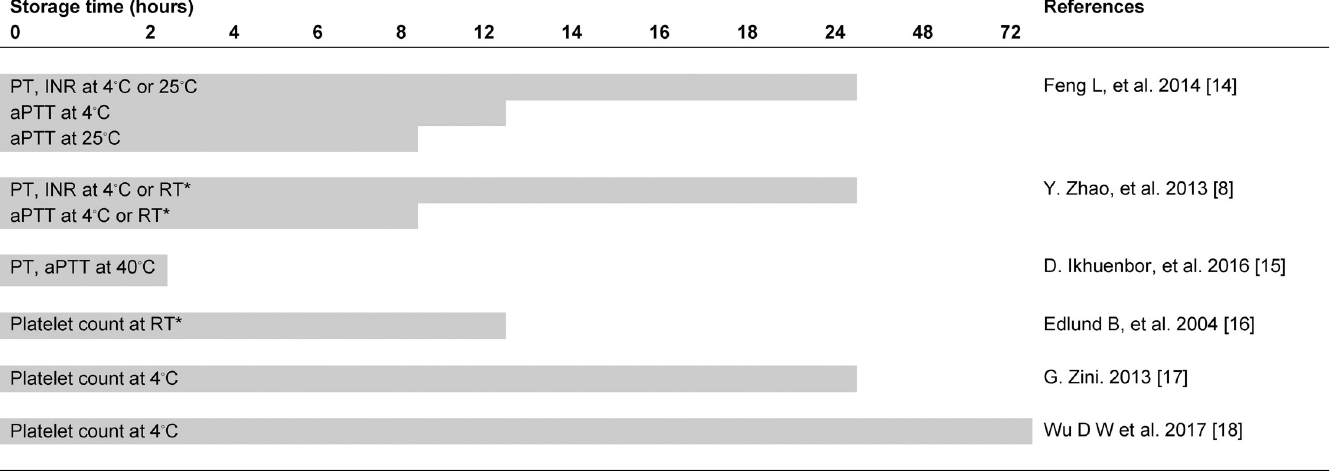
Fig 3. Different acceptable storage times of laboratory tests as proposed by previous